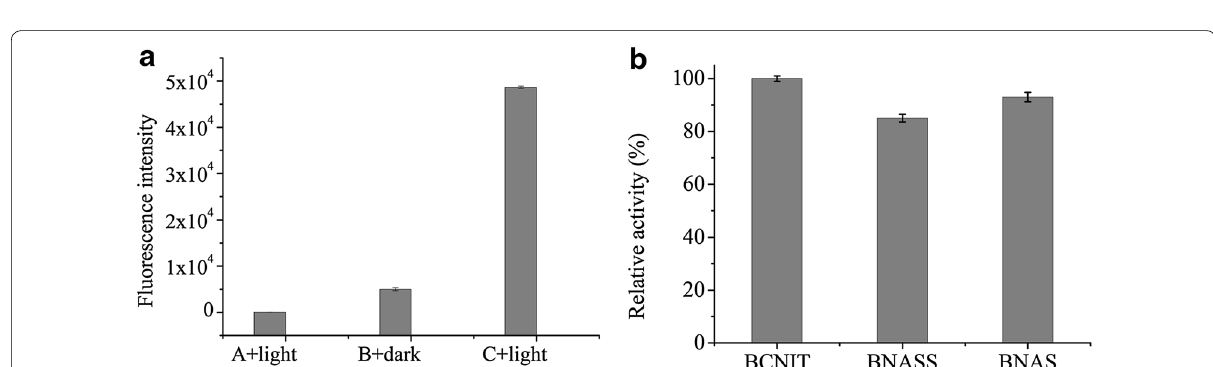
Fig. 7 The fluorescence intensities of fusion protein-coexpressing strains. a A light represents the strains coexpressing mN159, mC160, and SspB + under blue light illumination; B dark represents the strains coexpressing BCNIT-mN159-AsLOV2-SsrA (BNMnAS), BCNIT-mC160-AsLOV2-SsrA (BNM- + cAS), and SspB in the dark; C light represents the strains coexpressing BNMnAS, BNMcAS, and SspB under blue light illumination. b Comparison + of the nitrilase activities of BCNIT, BNAS, and BNASS in E. coli . Error bars represent the standard error of three replicates. The determination of nitrilase activity was performed at 30 °C for 30 min with 10 µM FMN under 470-nm blue light illumination. Under the experimental conditions, the relative activity was expressed as a percentage of the maximum activity. Error bars represent the standard error of three